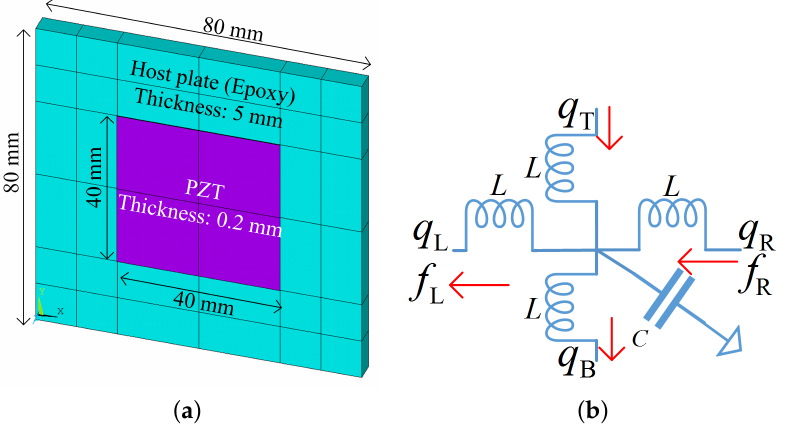
Figure 4. The unit cells of the uncoupled mechanical ( a ) and electric ( b ) systems. Note that the thickness of the shell elements is illustrated in ( a ).